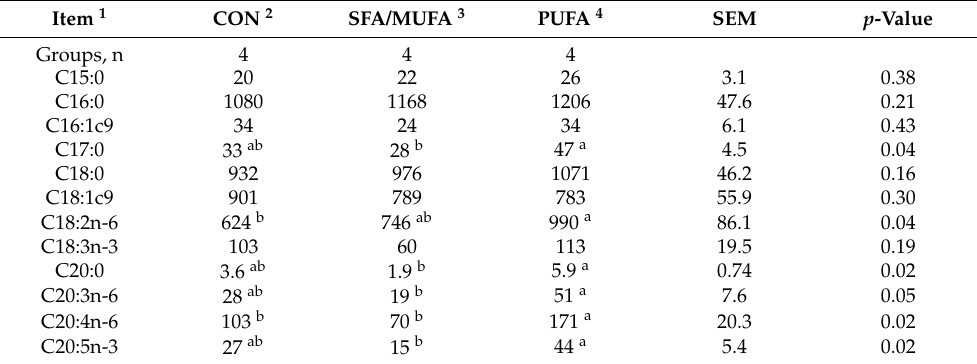
Table 9. Effects of supplementation of soybean hulls mixed with either whole-shelled corn (CON), Ca salts of saturated/monounsaturated fatty acids (SFA/MUFA), or Ca salts of polyunsaturated fatty acids (PUFA) for the last 82 ± 5 d of gestation on the relative concentrations of selected plasma fatty acids in steers at birth 1 .